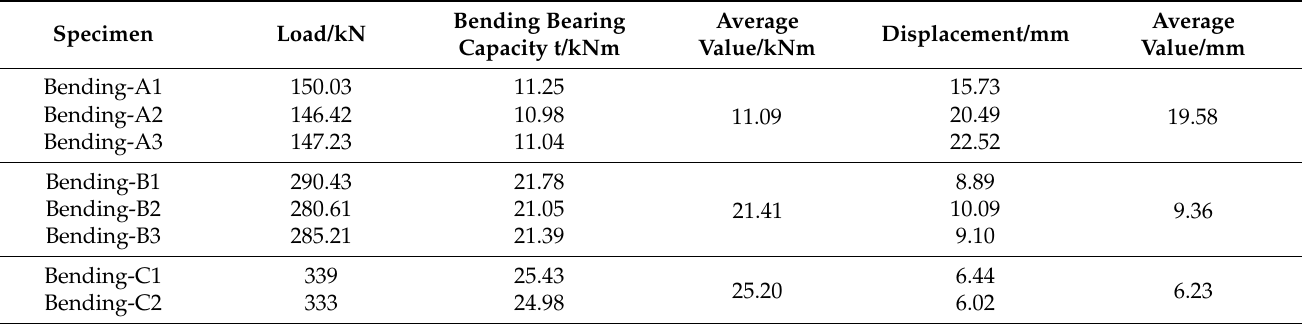
Table 3. The results of the bending